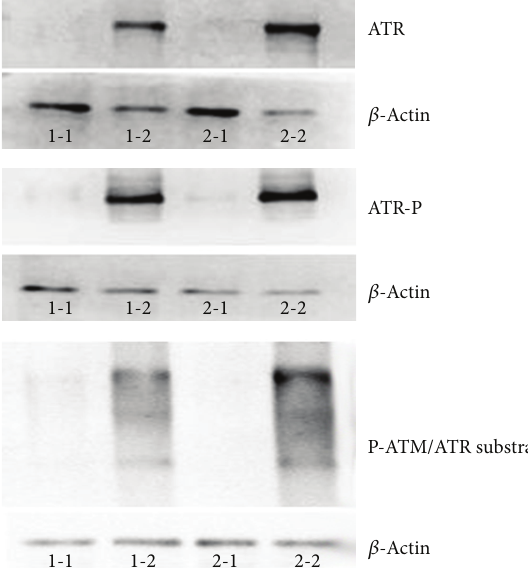
Figure 7: Culture of BMMNCs with media containing SAA serum increases activation of ATR. Legend: Samples 1-1 and 2-1: BMMNCs fromtwoindividualcontrolpatientsculturedwith1640media+10% FBS. Samples 1-2 and 2-2: BMMNCs from the same two individual control patients cultured with 1640 media + 10% SAA serum.